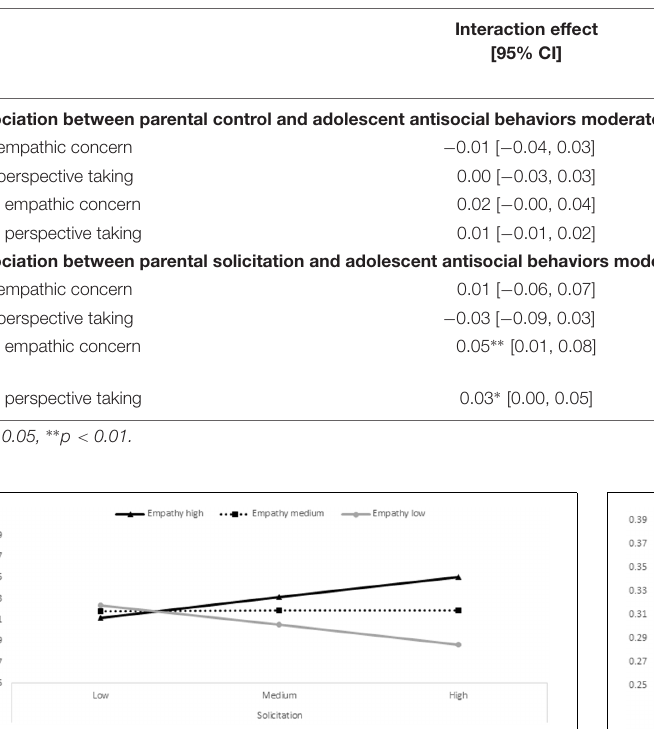
TABLE 2 | Results of moderation analyses.